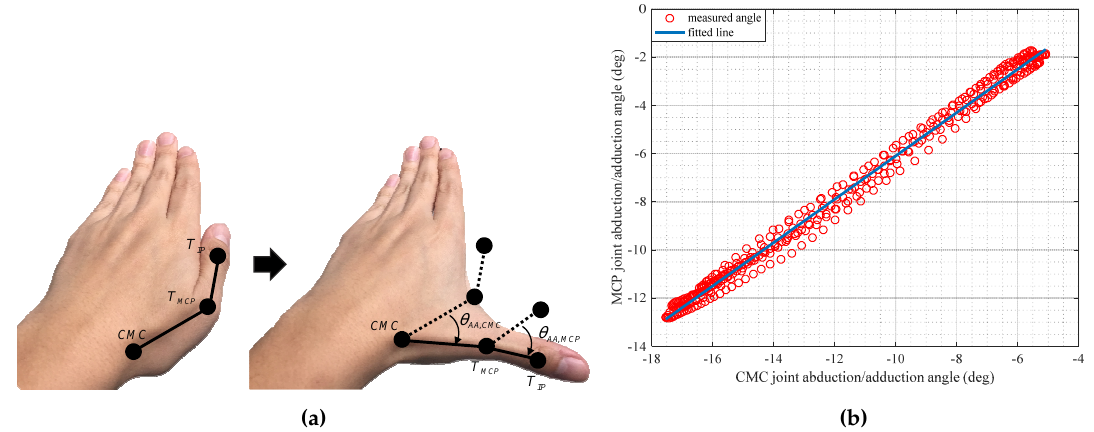
Figure 7. The relationship between the abduction/adduction of the carpometacarpal (CMC) and MCP joints; ( a ) Abduction/adduction of the CMC and MCP joints of the thumb; ( b ) Linear relationship between the CMC and MCP joint angles.